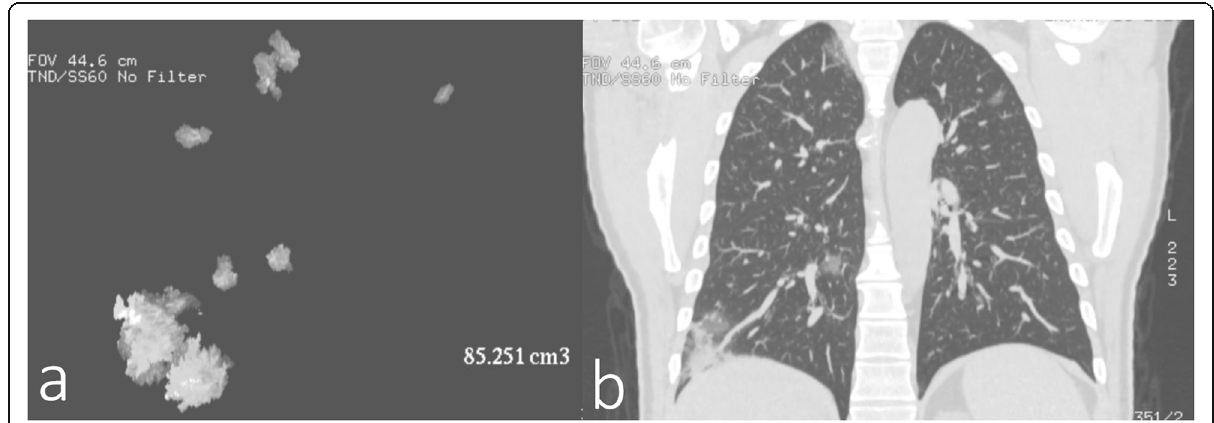
Fig. 2 Example of severe acute respiratory syndrome coronavirus 2 lung disease segmentation. a Maximum intensity projection coronal image shows segmented lung opacities and the volume provided in cubic centimeters. b Corresponding coronal computed tomography